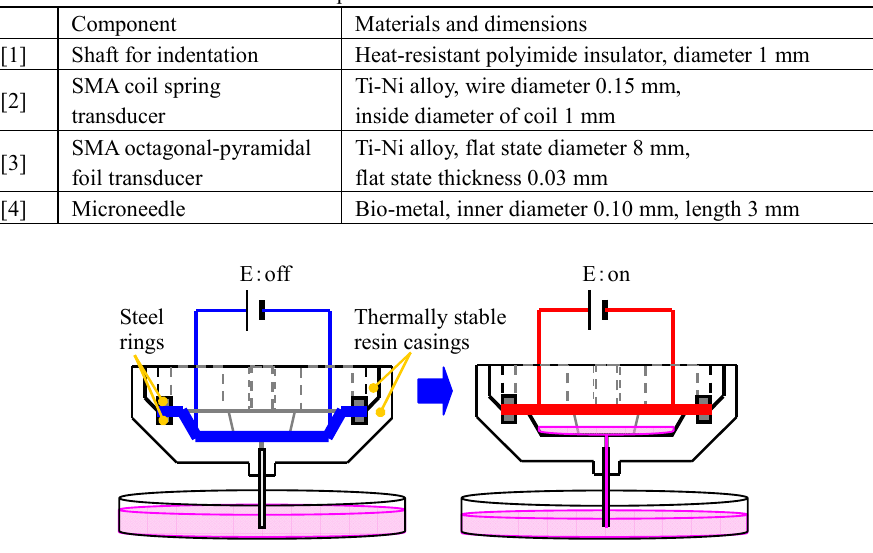
Figure 2. Blood suction by Joule’s heating of SMA octagonal-pyramidal foil